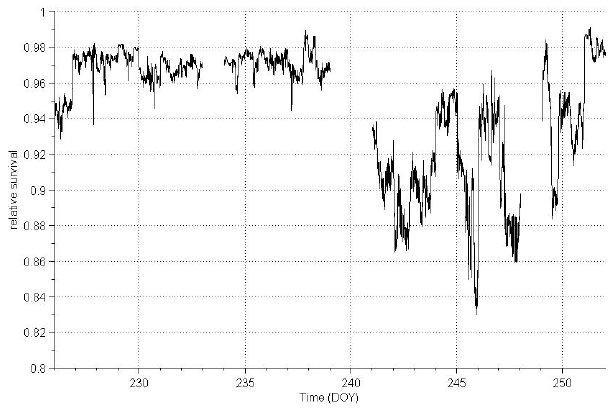
Figure 14. Calculated relative survival of particles during growth from 3 to